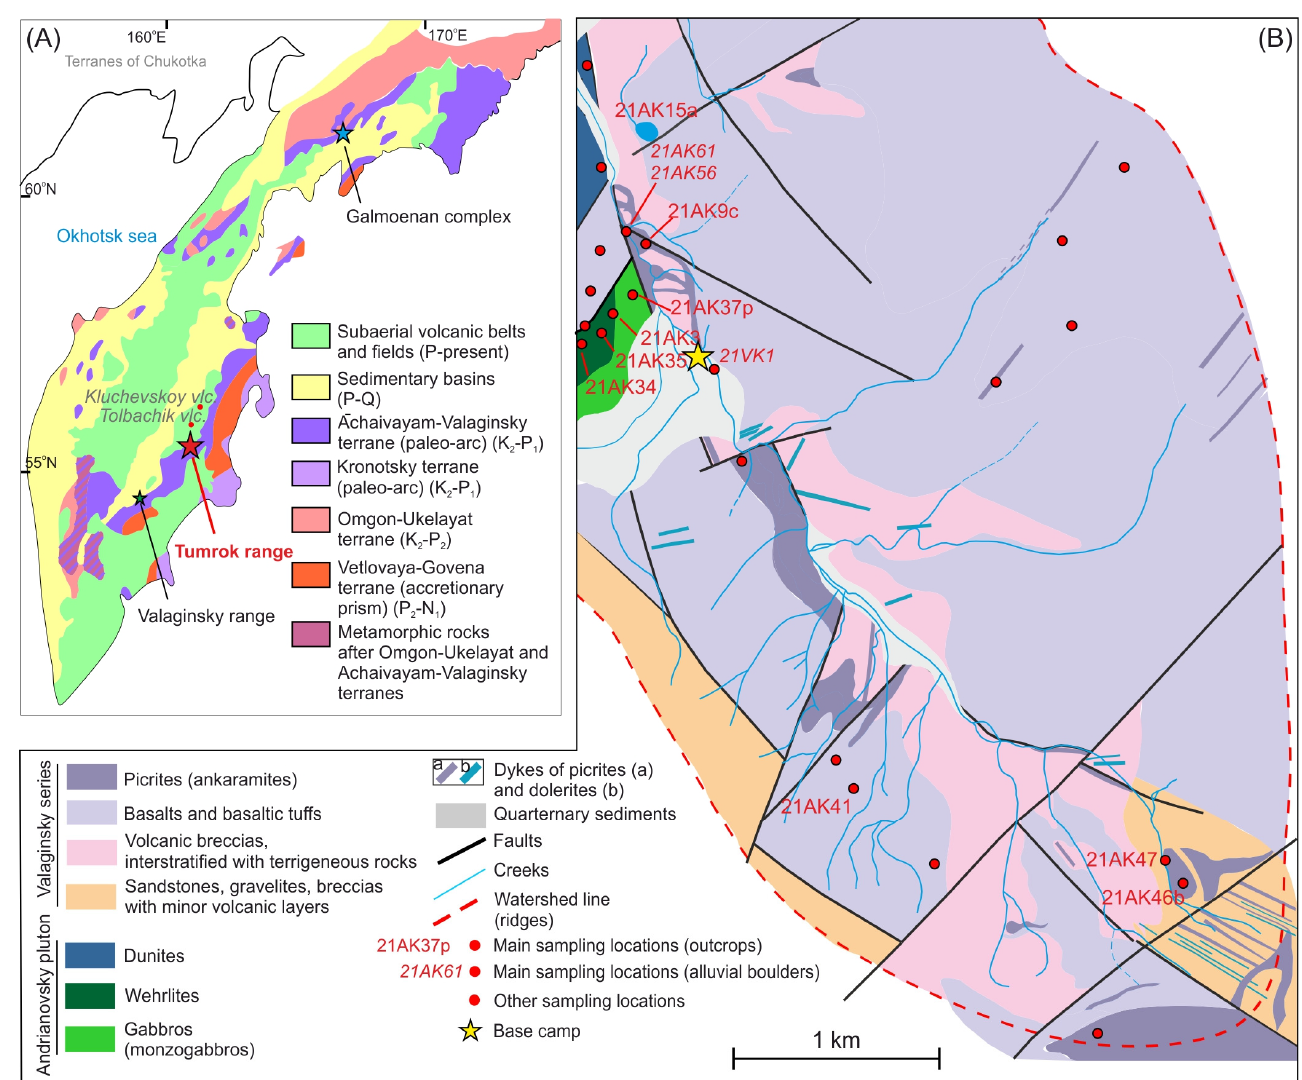
Figure 1. Geological setting of the studied complex. ( A ) Geological map of Kamchatka peninsula (after [55]); ( B ) geological scheme of the studied occurrence (after unpublished sketch of B. A. Markovskiy with the authors’ editions).